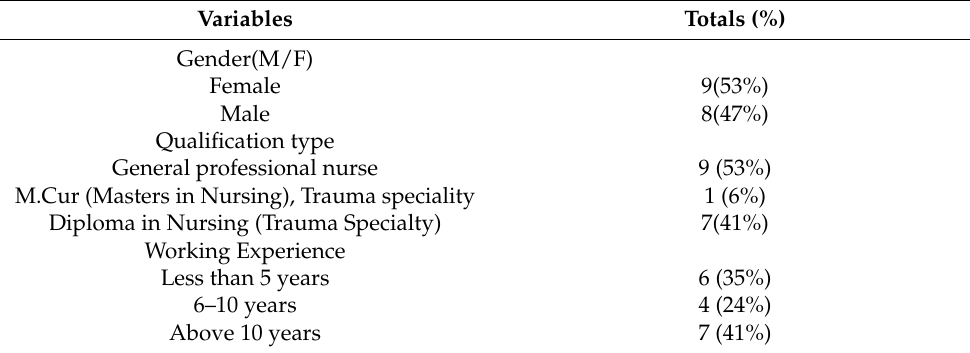
Table 2. Demographic data of participants ( N =